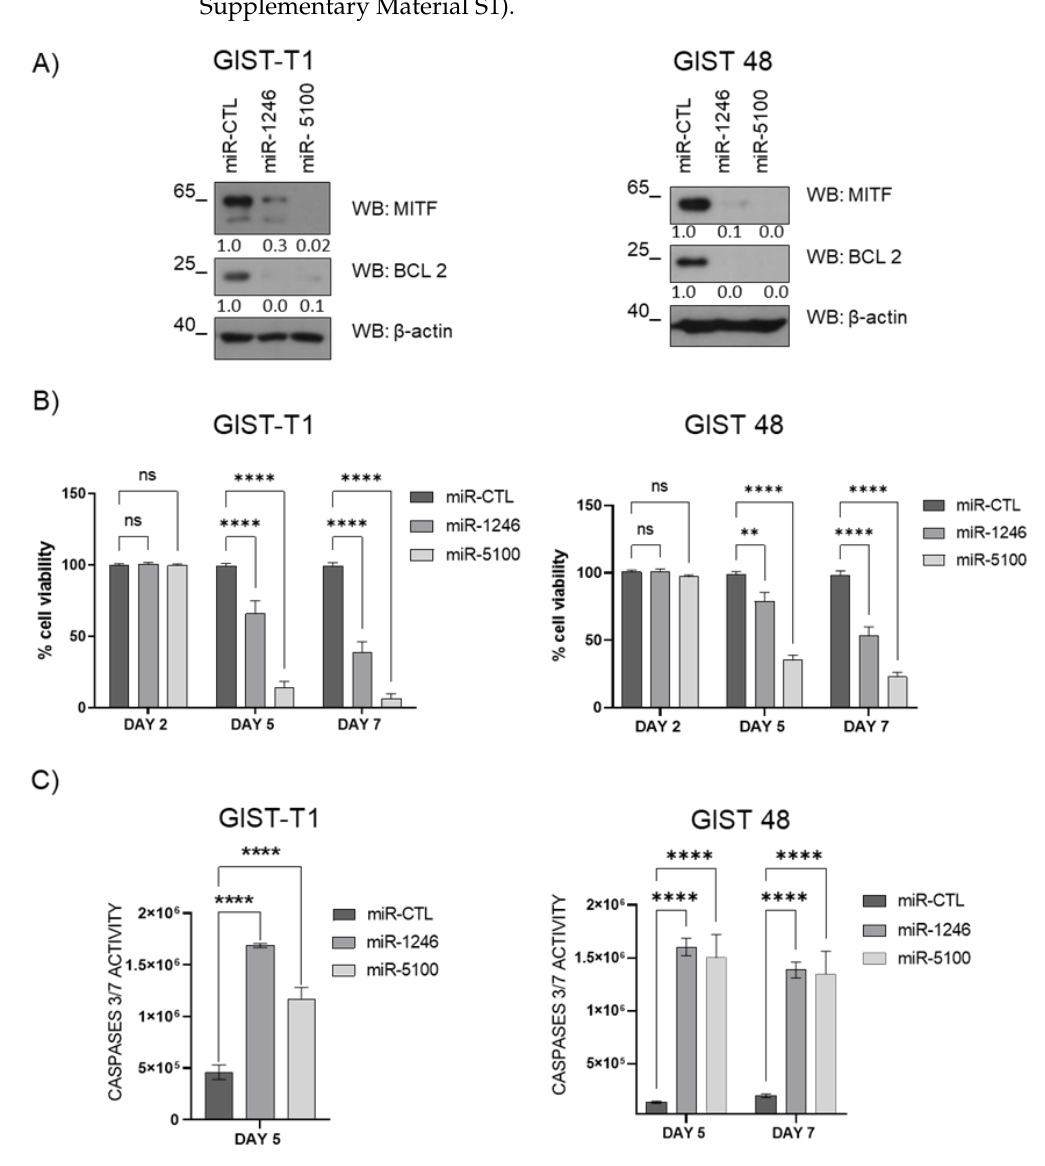
Figure 5. MiR-1246 and miR-5100 induce apoptosis in GIST cells. ( A ) Western blot was carried out on the 5th day after lentiviral transduction in GIST. MITF and BCL2 levels were assessed; β -actin was used as load control. ( B ) Viability was evaluated by crystal violet on the 2nd, 5th, and 7th days after lentiviral transduction. Statistical significance (* p < 0.05, ** p < 0.01, **** p < 0.0001; one-way-ANOVA with Bonferroni’s post -hoc test) GIST-T1 n = 4; GIST 48 n = 3. ( C ) Caspase 3/7 activity was measured on the 5th day on GIST-T1; the 5th and 7th day on GIST 48 post lentiviral transduction (**** p < 0.0001; Unpaired T -test; mean ± SEM) n = 3. GFPmiR-CTL was used as a control.